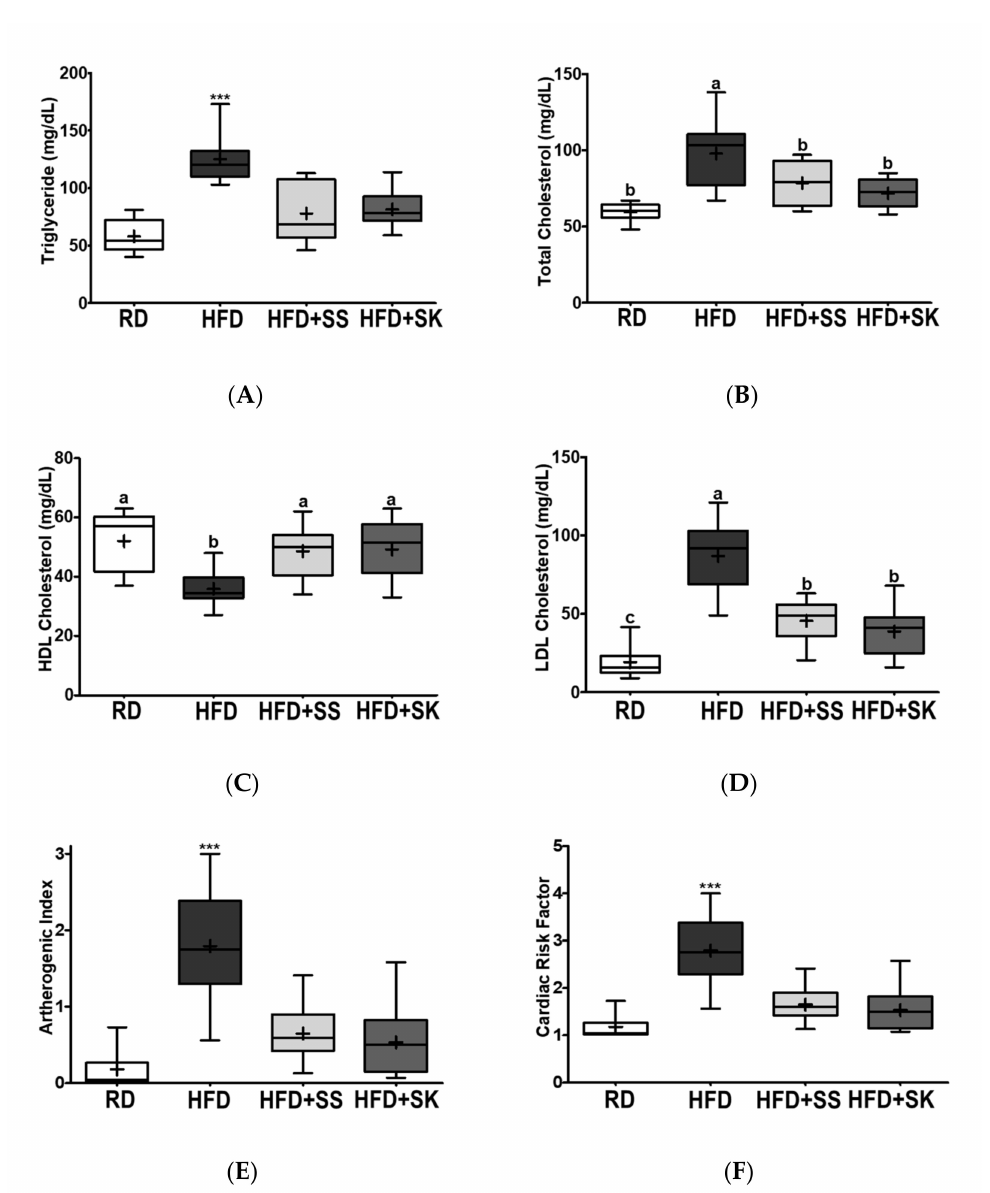
Figure 4. Effect of steamed soybean (SS) and soybean koji (SK) on lipid panels, atherogenic index, and cardiovascular disease risk factors. Experimental rats were fed a regular diet (RD) or a high-fat diet (HFD) with 3% SS (HFD+SS) or with 3% SK (HFD+SK) for 8 weeks. Serum levels of ( A ) triglyceride (TG), ( B ) total cholesterol (TC), and ( C ) high-density lipoprotein-cholesterol (HDL-C) were measured in the experimental rats. ( D ) Low-density lipoprotein-cholesterol (LDL-C), ( E ) atherogenic index (AI), and ( F ) cardiac risk factor (CRF) were processed. RD, regular diet; HFD, high-fat diet; HFD+SS, high-fat diet + 3% steamed soybean; HFD+SK, high-fat diet + 3% steamed soybean. Values are displayed as a box-and- whisker plot with means (expressed as ‘+’), n = 8. Data were analyzed using one-way ANOVA followed by Tukey’s post-hoc comparison. Means labeled without a common letter differ significantly, p < 0.05. *** p <